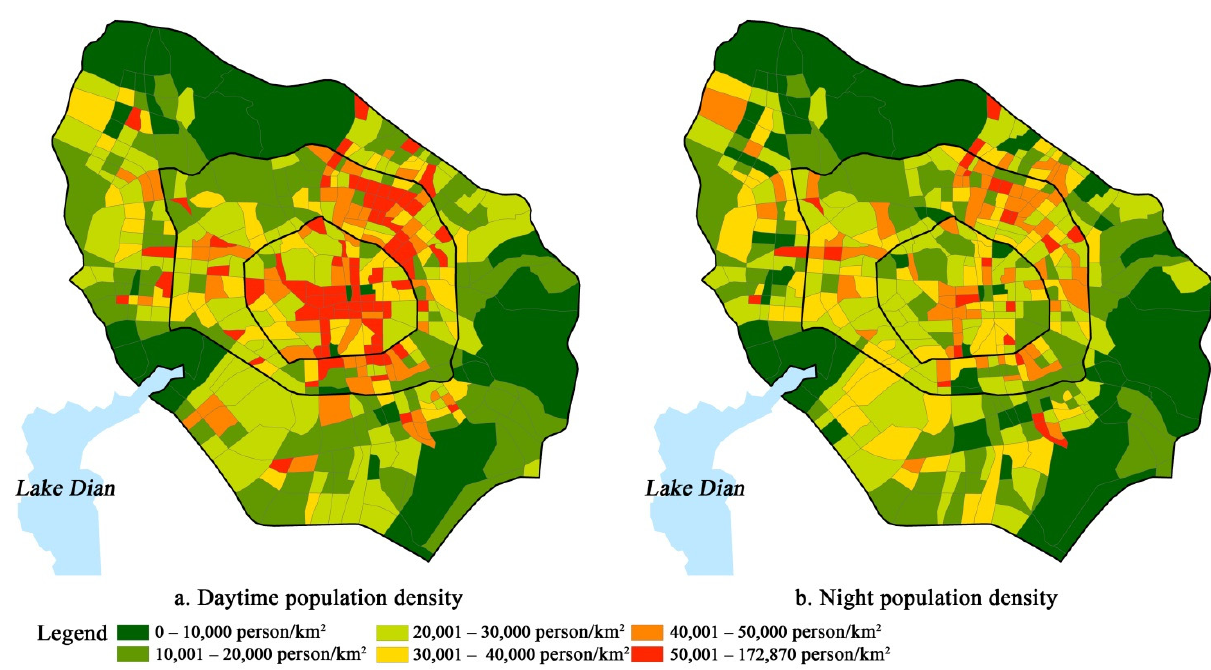
Figure 6. The spatial difference pattern of population density in Kunming’s Main Urban District.